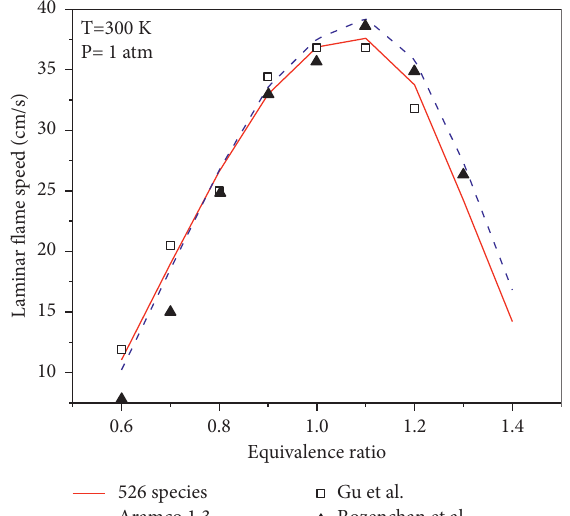
Figure 4: Laminar flame speed validation for methane. The experimental data used for comparison were taken from Gu et al. [53] and Rozenchan et al.